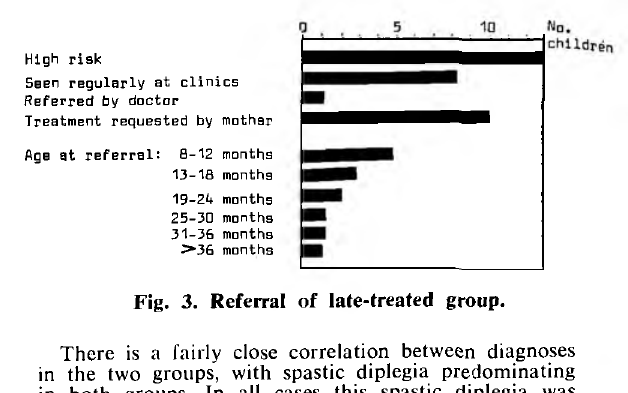
Quadriplegia Diplegia Hemiplegia Fig. 4. Diagnosis.